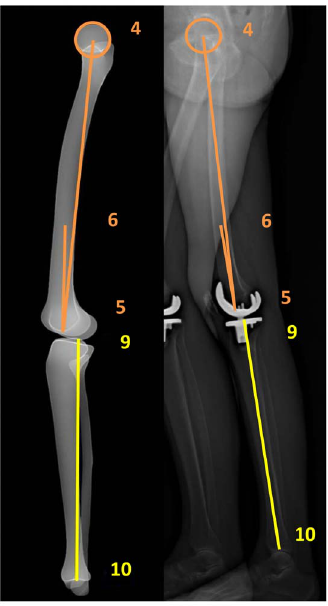
Figure 2. Identification of the lower limb on the lateral image.